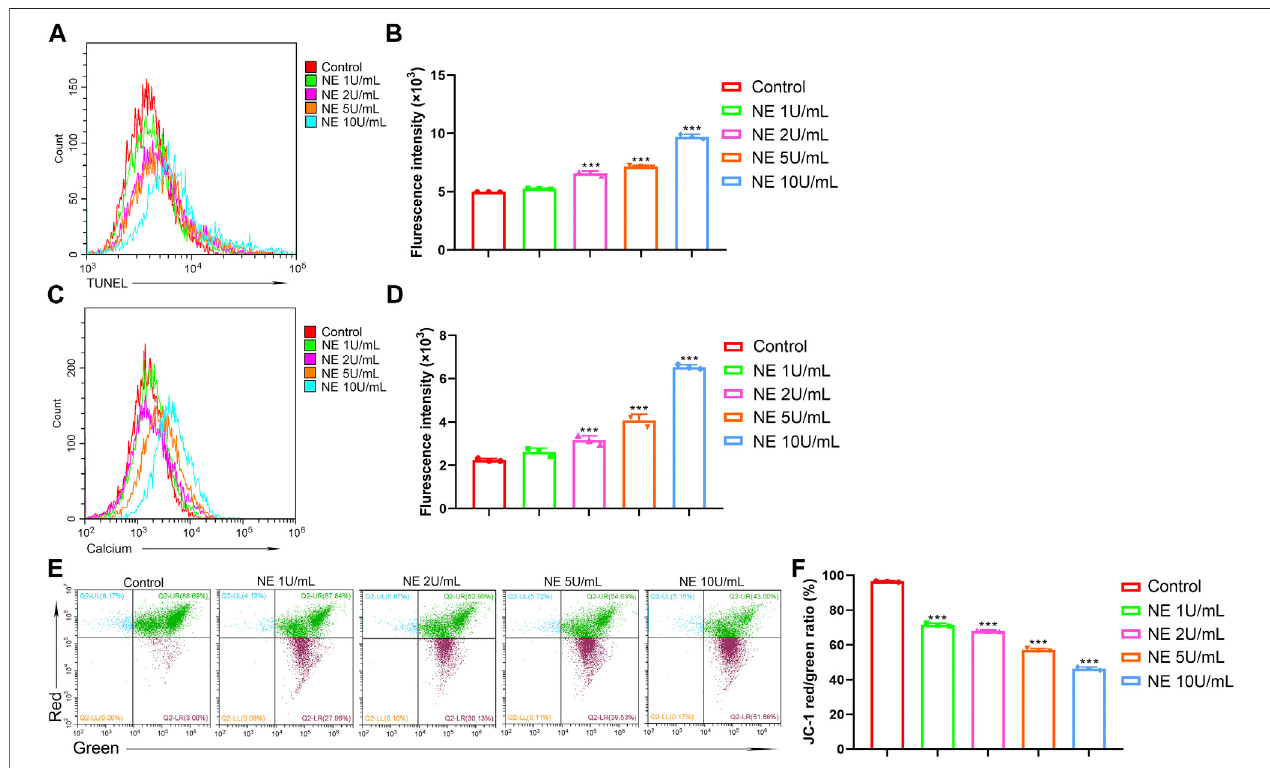
FIGURE 4 | Neutrophil elastase induces DNA fragmentation, mitochondrial disruption and intracellular calcium release of chondrocytes. (A,B) TUNEL levels of chondrocytesweremeasuredby fl owcytometry. (A) Representativehistogramswereshown. (B) Cellassociatedmeanrelative fl uorescenceintensities.Dataaremean ± SEM; n (cid:1) 3. *** p < 0.001. (C,D) Intracellular free Ca 2+ of chondrocytes were measured by fl ow cytometry. (C) Representative histograms were shown. (D) Cell associated mean relative fl uorescence intensities. Data are mean ± SEM; n (cid:1) 3. *** p < 0.001. (E,F) JC-1 staining of chondrocytes were measured by fl ow cytometry. (E) The fl uorescence pattern of JC-1 staining chondrocytes. (F) Red/Green fl uorescence intensities. Data are mean ± SEM; n (cid:1) 3. *** p <